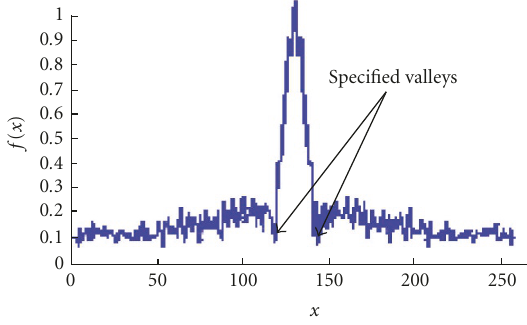
Figure 7: f ( x ) of an image with no additive noise. Figure 8: f ( x ) of an image corrupted by linear motion blur with L = 30 pixels and additive Gaussian noise (SNR =